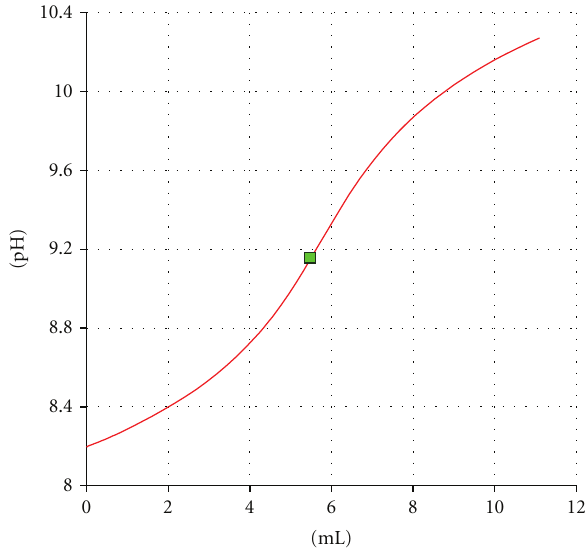
Figure 5: The typical titration curve of the Na 2 HPO 4 /NaH 2 PO 4 solution obtained as filtrate from the wood suspension.